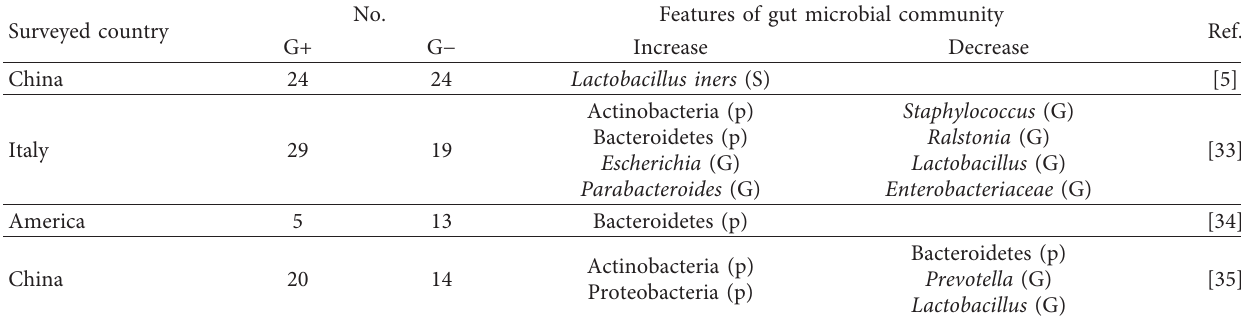
Table 2: Changes of gut microbiota in the newborns of GDM mothers compared with the newborns of mothers without GDM. No. Features of gut microbial Surveyed country